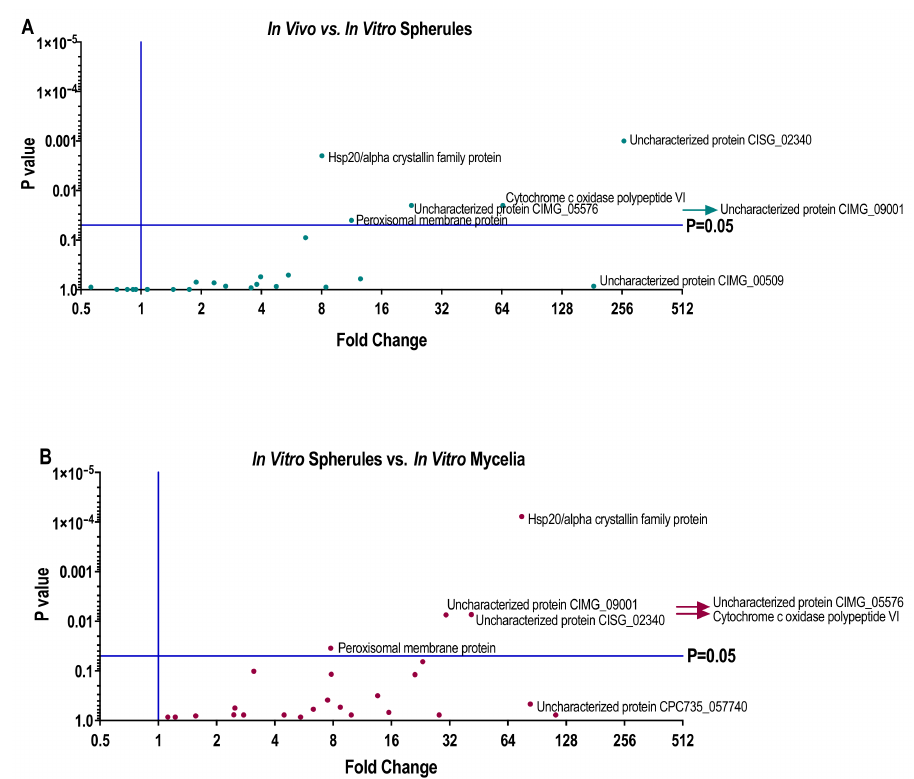
Figure 4. Volcano plots of the 27 biomarker candidate proteins indicate large fold change of protein abundances (NSAF) between in vivo and in vitro grown proteins. ( A ) Fold change of relative protein abundances of LCM lung tissues in relation to the spherule form. ( B ) Fold change of relative protein abundances in the spherule form in relation to the mycelial form. Proteins next to arrows had a significant p value, but as they did not grow in vitro (had NSAF value of 0), could not calculate a fold change. Volcano plots produced in GraphPad Prism v.8, using multiple t tests of NSAF, corrected for multiple comparisons using Holm–Sidak method. J. Fungi 2020 , 6 , x FOR PEER REVIEW